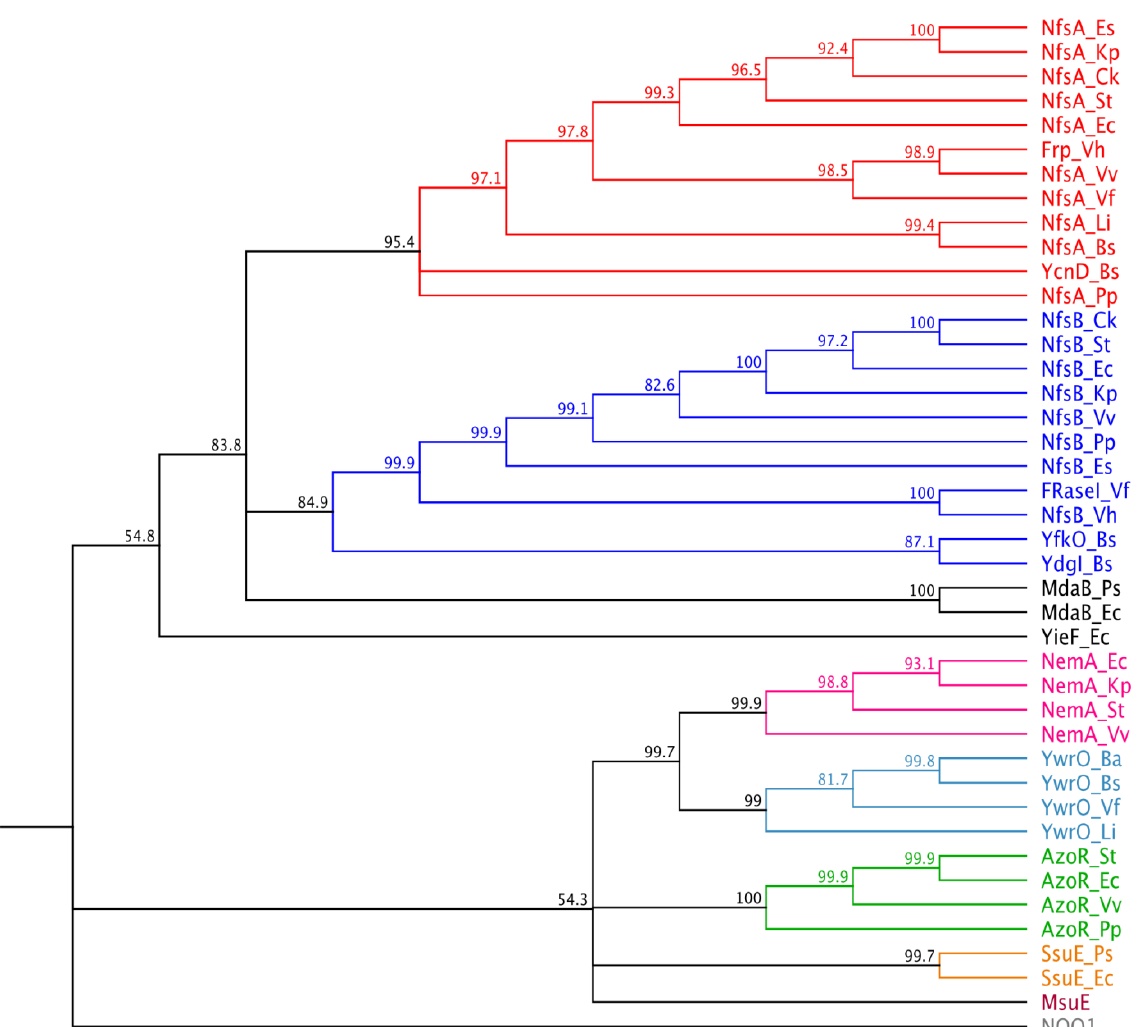
Figure 2. Phylogenetic analysis of MsuE and other experimentally validated bacterial nitroreductase families. MsuE (dark red) and two SsuE orthologues from E. coli and Pseudomonas syringae pv. tomato DC3000 (orange) were genetically aligned against members of the NfsA (red), NfsB (dark blue), MdaB (black), YieF (black), NemA (pink), YwrO (light blue) and AzoR (green) nitroreductase families, and a human NQO1 out-group (grey), using the online tool ClustalW2. With the exception of the msuE and ssuE genes, nitroreductase sequences are as previously presented by Prosser et al. [14]. Following the nomenclature of that paper, the two letter suffix following the enzyme name indicates the bacterial strain of origin: Ba, B. amyloliquefaciens ; Bs, Bacillus subtilis ; Ck, Citrobacter koseri ; Es, Enterobacter sakazakii ; Ec, Escherichia coli ; Kp, Klebsiella pneumonia ; Li, Listeria innocua ; Pa, Pseudomonas aeruginosa ; Pp, Pseudomonas putida ; Ps, Pseudomonas syringae ; St, Salmonella typhi ; Vf, Vibrio fischeri ; Vh, Vibrio harveyi ; Vv, Vibrio vulnificus . The phylogenetic tree was constructed using the online tool MrBayes 3.2.1 [27] and bootstrap confidence values are indicated at major branchpoints. The final figure was generated using Geneious version 6.1